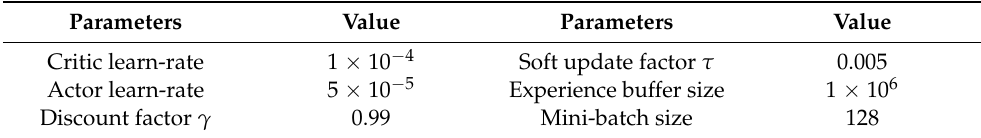
Table 2. Hyperparameters of the